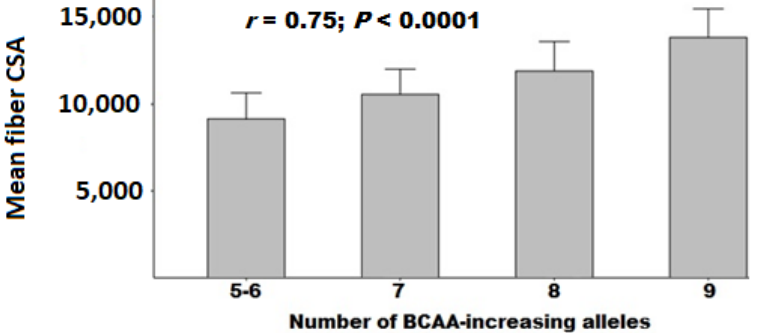
Figure 1. Mean all (slow-twitch + fast-twitch) muscle fiber CSA ( µ m 2 ) in participants consuming WPS according to number of BCAA-increasing alleles.